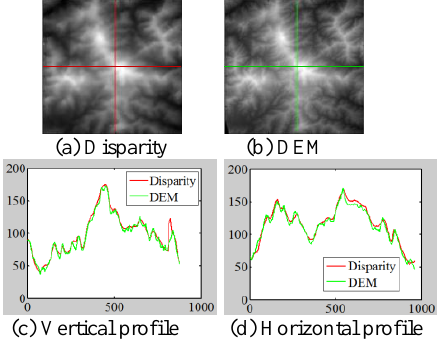
Figure 11. Comparison between the generated disparity map and original